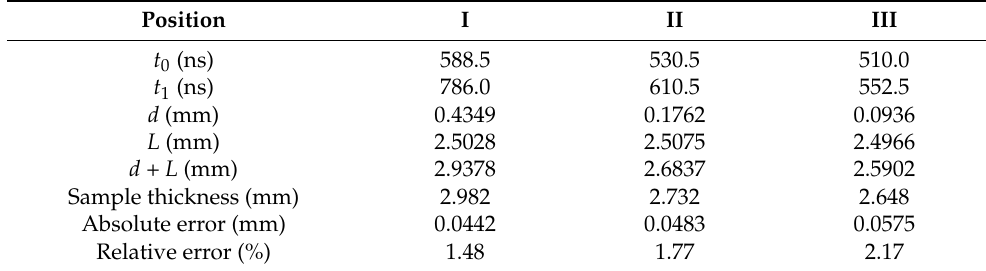
Table 3. The experimental data and calculated